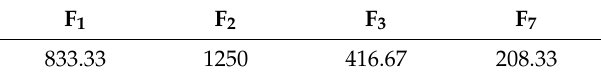
Table 3. Repair probability of protection device (10 − 4 h − 1 ).